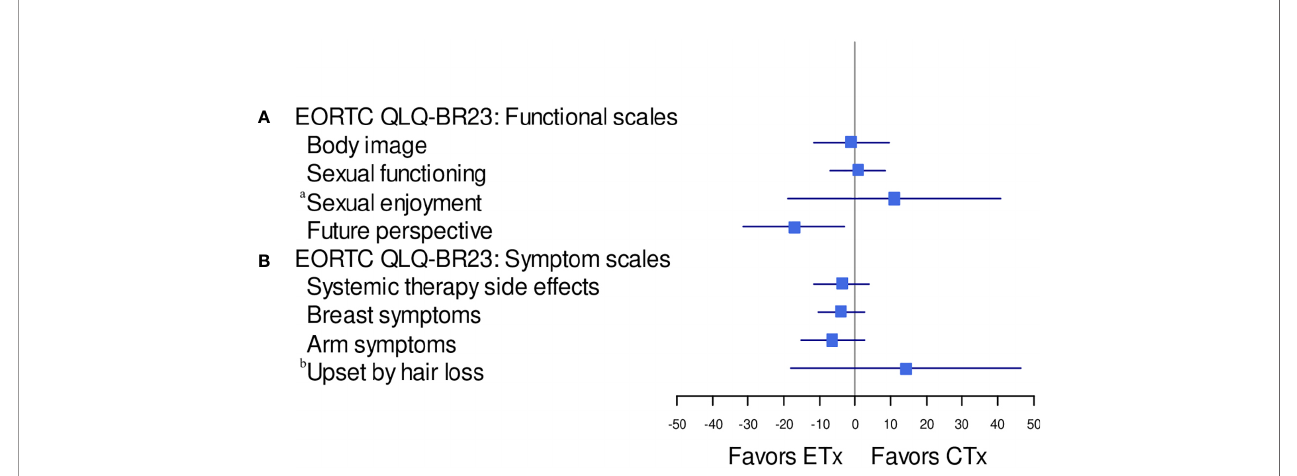
FIGURE 2 | Forest plot model of estimated difference (NET: ETx vs. NCT: CTx) in overall change from baseline (repeated-measures mixed-effect model) in PRO-evaluable population. CTx, chemotherapy; EORTC, European Organisation for Research and Treatment of Cancer; ETx, endocrine therapy; NCT, neoadjuvant chemotherapy; NET, neoadjuvant endocrine therapy; PRO, patient-reported outcome; QLQ-BR23, Quality of Life Questionnaire Breast Cancer Module; QoL, quality of life. (A) EORTC QLQ-BR23: functional scales, (B) EORTC QLQBR23 symptom scales. a The sample sizes for the "sexual enjoyment" functional scale were smaller than other functional scales because patients were asked to respond question that they were sexually active. b The sample sizes for the "upset by hair loss" symptom scale were smaller than other symptom scales because patients were asked to respond to this question only if they responded in a previous question that they were experiencing hair